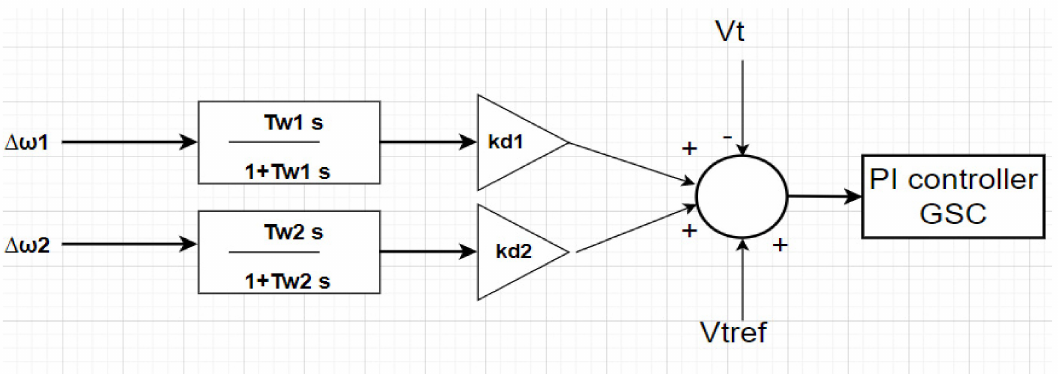
Figure 14. Structure of damping controller with optimization methods.